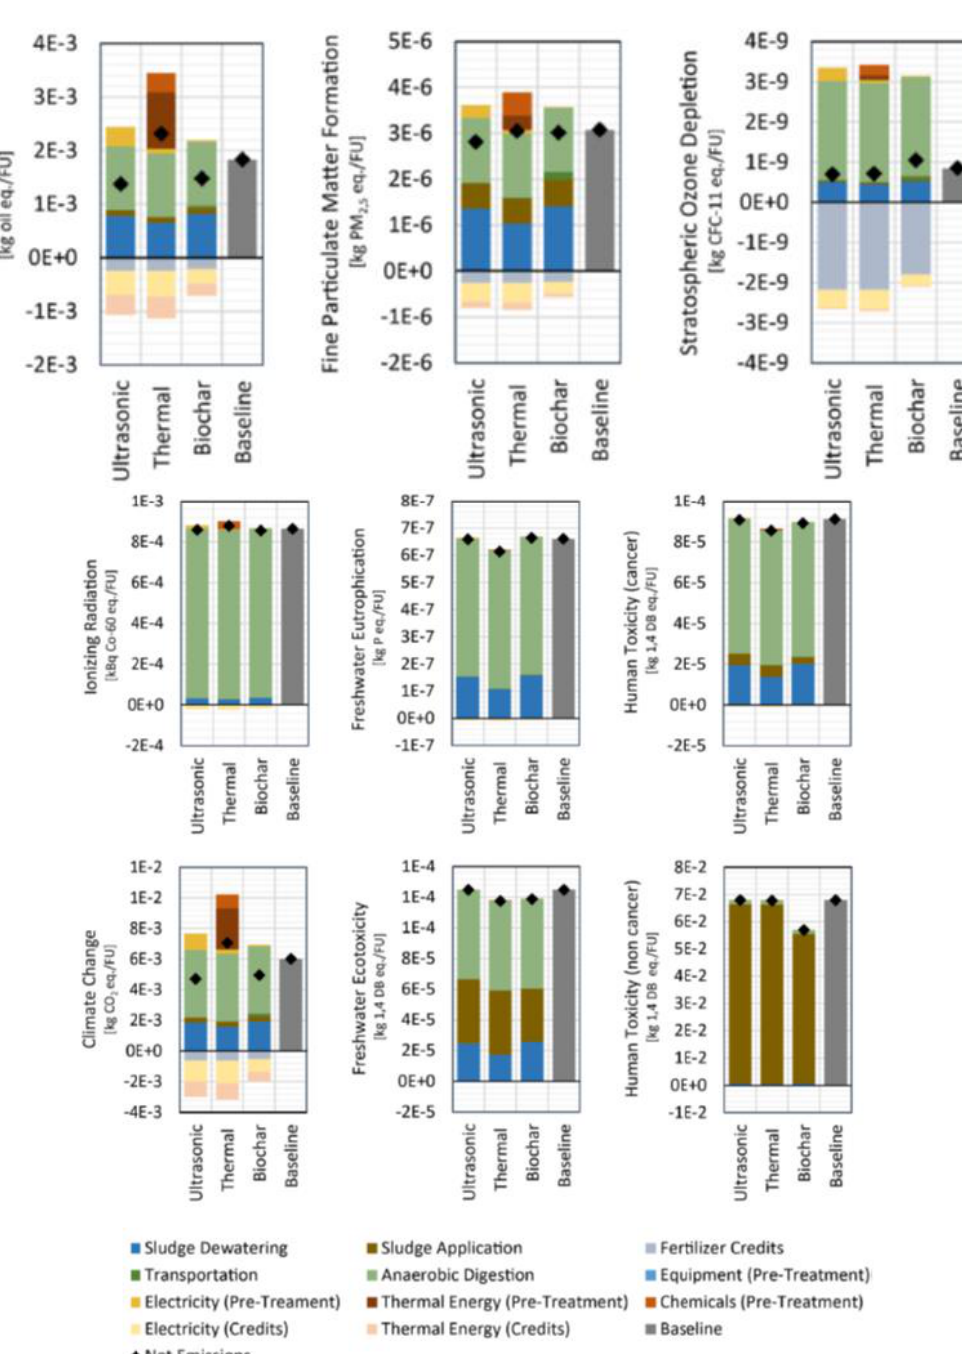
Figure 4. Comparison of ultrasonic, thermal, and biochar LCIA results with the baseline scenario at an industrial scale. Copyright 2021 by Elsevier [11]. an industrial scale. Copyright 2021 by Elsevier